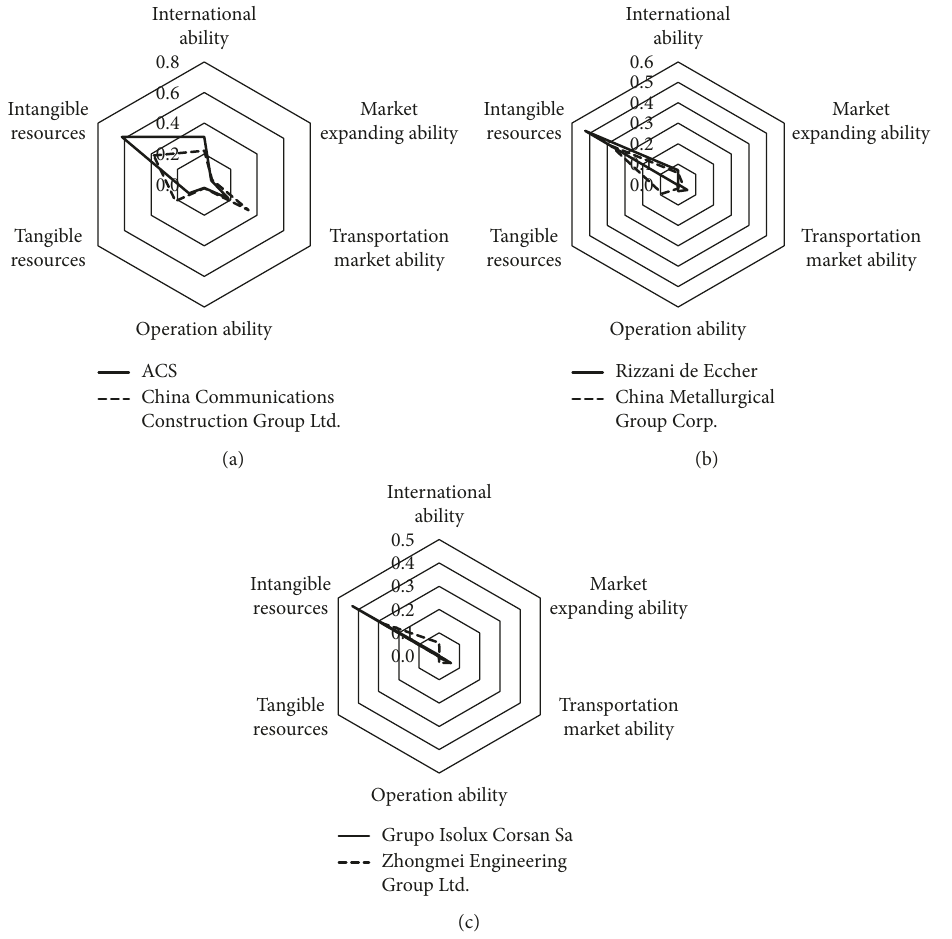
Figure 7: Comparisons between Chinese and European